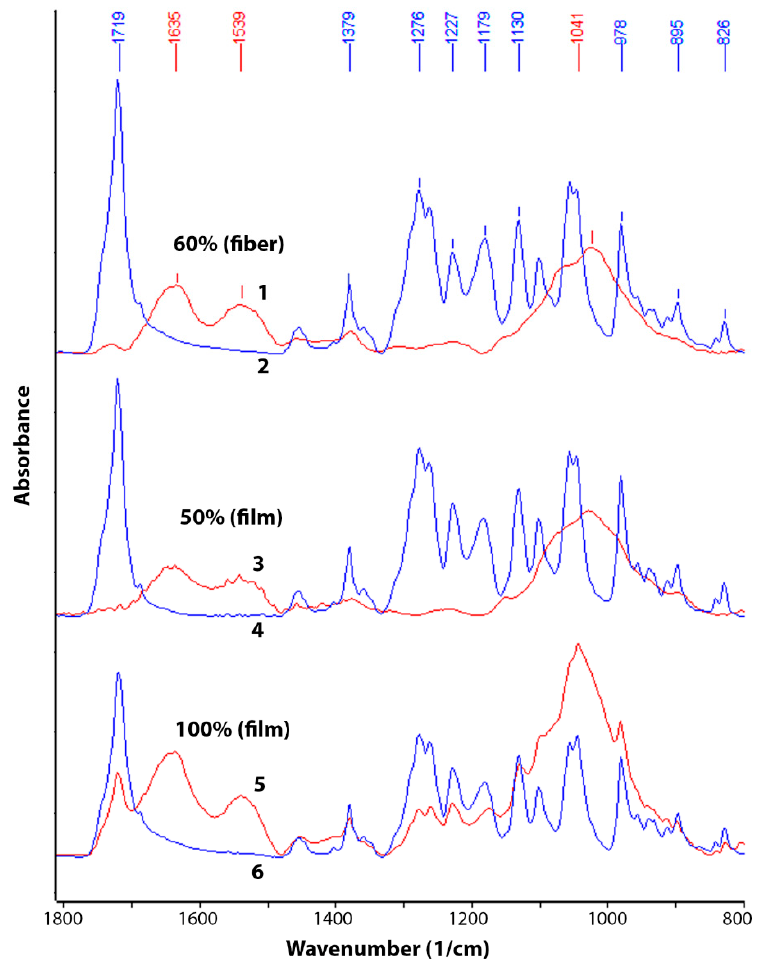
Figure 4. IR spectra (ATR method) in the wavelength range 800–1800 cm − 1 of the initial samples (2, 4, 6) and samples after 60 days of testing by the Sturm method (1, 3, 5): PHB/CHT (fiber)—(60/40) (1 and 2), PHB/CHT (film)—(50/50) (3 and 4), PHB (film) (5 and 6). 265